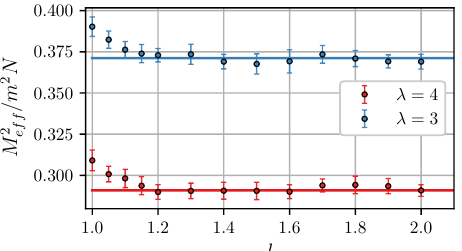
Figure 3. Normalized squared effective magnetic moment of Cluster I vs. the intercluster separation at ξ = 0 and ϕ = 0.3. Symbols are simulation results for N = 100, and solid lines are from MMFT [Equations (15)–(18)]. Different colors correspond to different λ (see